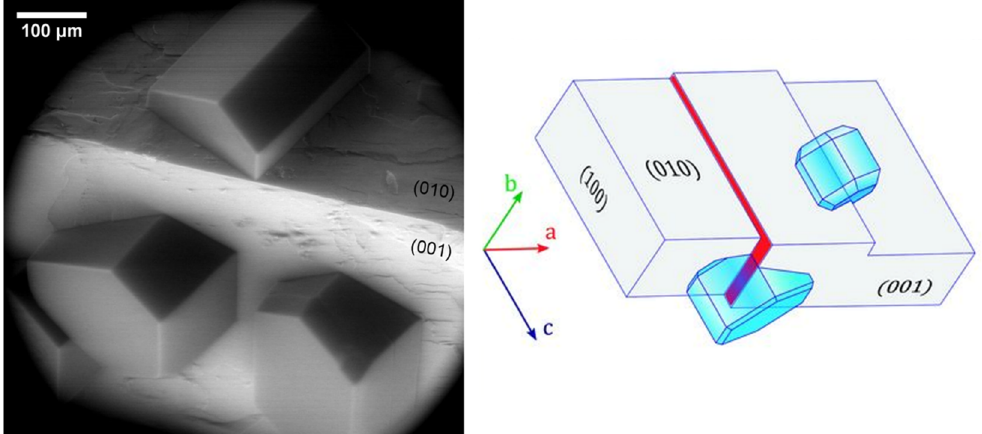
Figure 4. ( Left ) Preferential orientation of ice crystals nucleated on the surface of weathered feldspar on (010) and (001) surface at 241 K. ( Right ) Schematic drawing of ice crystals nucleating from their (0110) planes on the steps with (100) orientation (red filled surface and the hidden face of the step on the (010) face of feldspar). Adapted with permission from [8]. Copyright 2021 American Association for the Advancement of Science.